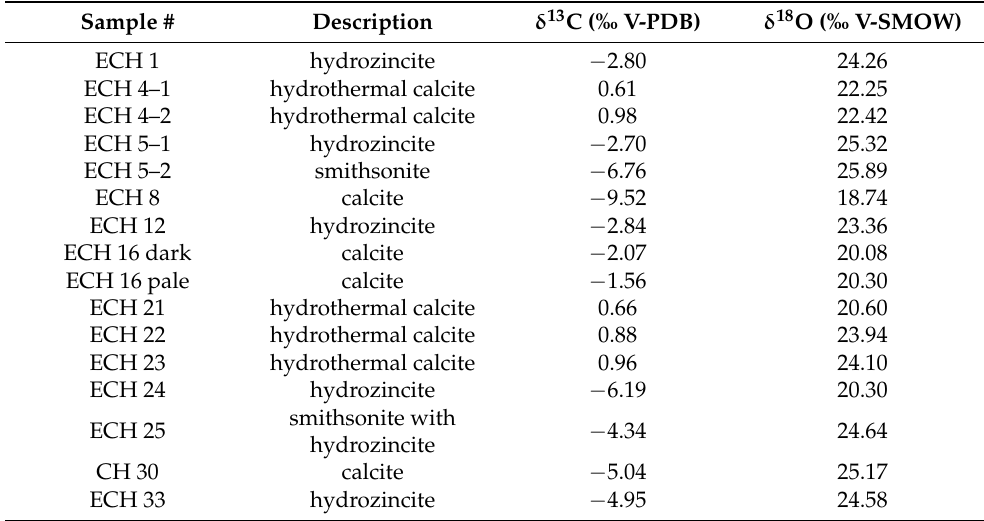
Table 5. Carbon and oxygen isotope compositions of selected carbonates from the Bou Caïd